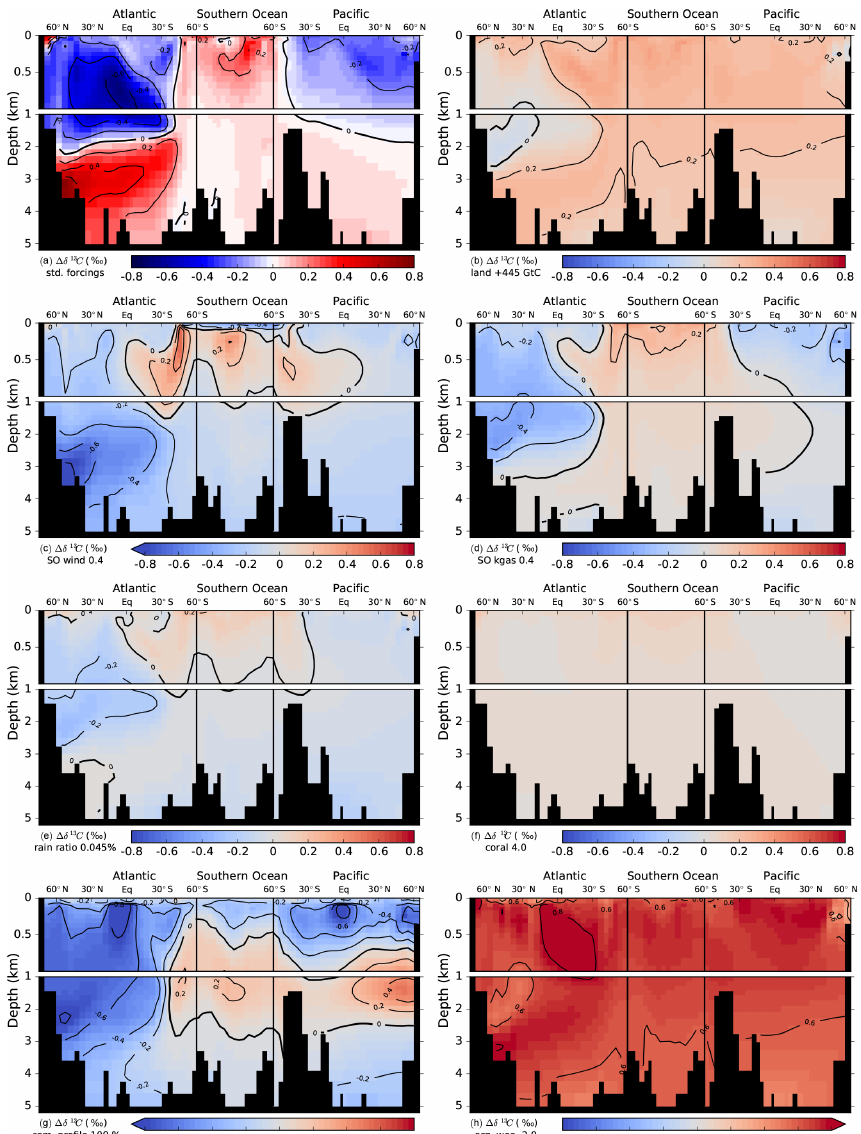
Figure 9. Simulated deglacial change in the isotopic signature of DIC, (cid:49)δ 13 C DIC (PI minus LGM). Values are displayed along sections across the Atlantic, Southern Ocean, and Pacific and in response to standard deglacial forcings (b–h) due to changes in individual mechanisms as inferred from factorial simulations. (cid:49)δ 13 C DIC is shown for a deglacial carbon uptake of 445GtC by the land biosphere (b) , Southern Ocean wind stress (c) , and gas transfer rate (d) scaled by a factor of 0.4 during the glacial relative to PI, rain ratio reduced to 0.045 during the glacial (e) , deglacial shallow water carbonate deposition scaled by a factor of 4 (f) , a change in the organic matter remineralization between a linear profile during the glacial and the standard depth scaling (g) , and for a twofold increase in the organic weathering flux during the glacial compared to PI (h) . The absolute change in (cid:49)δ 13 C DIC is shown in panel (a) for the standard forcings (bright colors), while panels (b) to (h) show the difference relative to the standard run (pastel